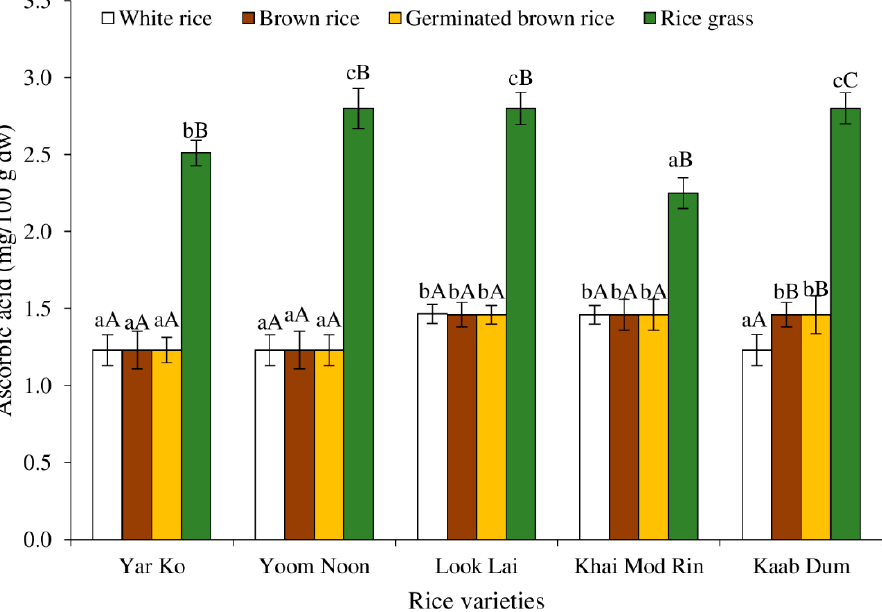
Figure 3. Effect of rice variety and processing condition on ascorbic acid content of Thai indigenous rice. Bars represent the standard deviations from triplicate determinations. Different lowercase letters within the same processing condition indicate significant differences ( p ˂ 0.05). Different uppercase letters within the same variety indicate significant differences ( p ˂ 0.05).